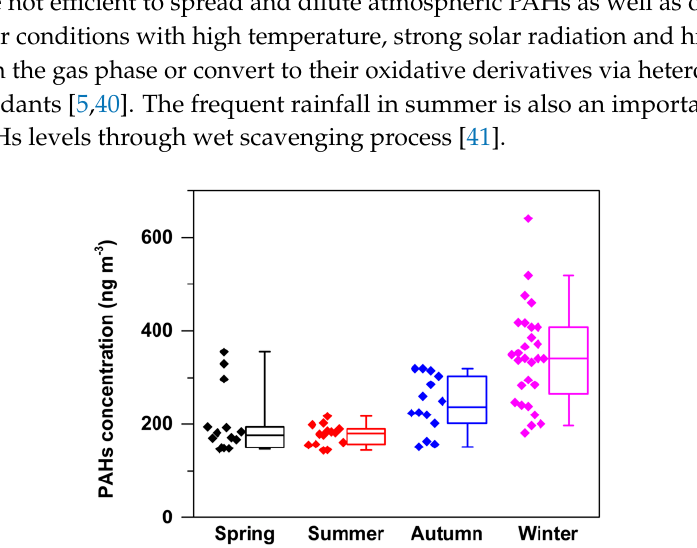
Figure 4. Seasonal variation of the proportions of 3- to 6-ring PAHs.